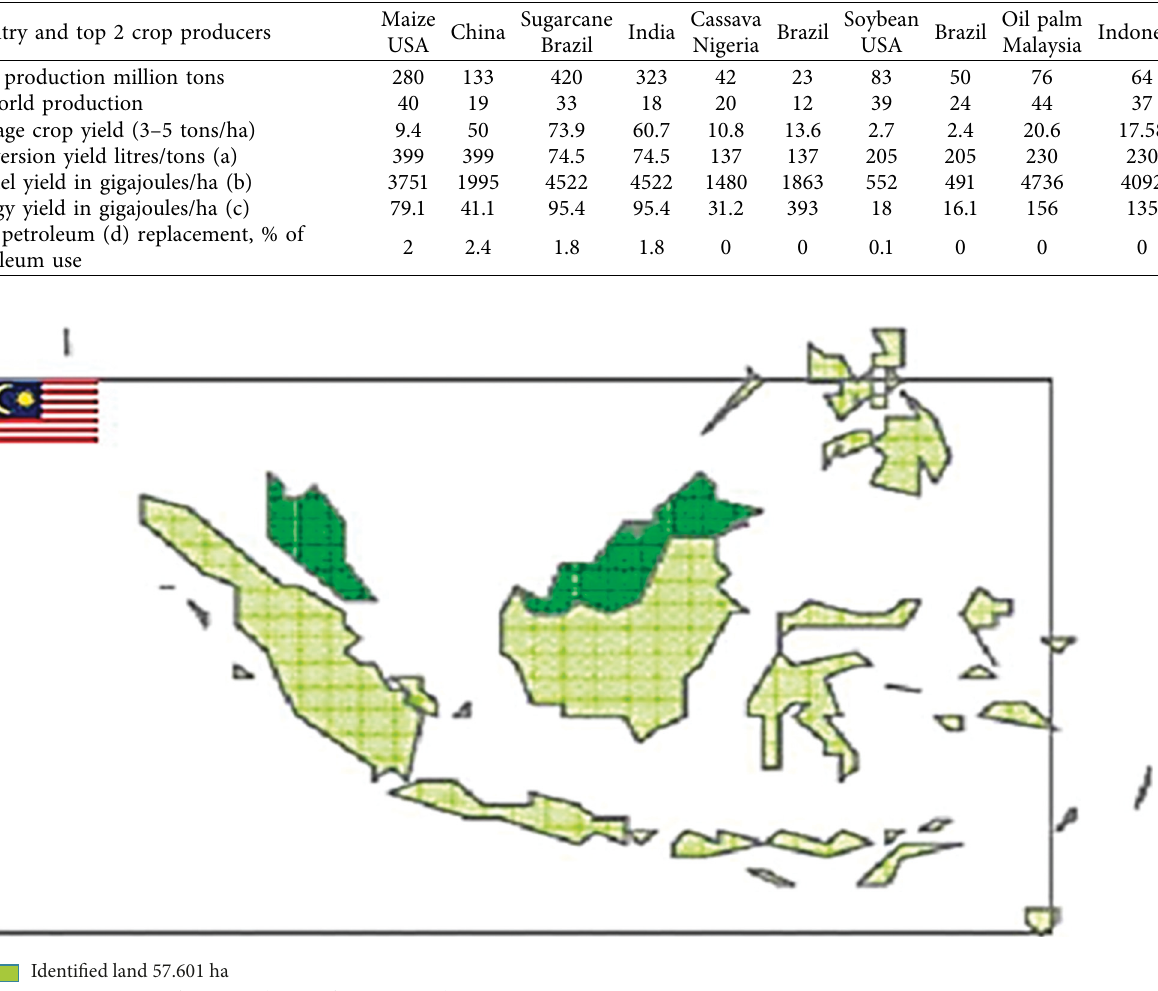
Figure 1: Land for Moringa oleifera in Ghana